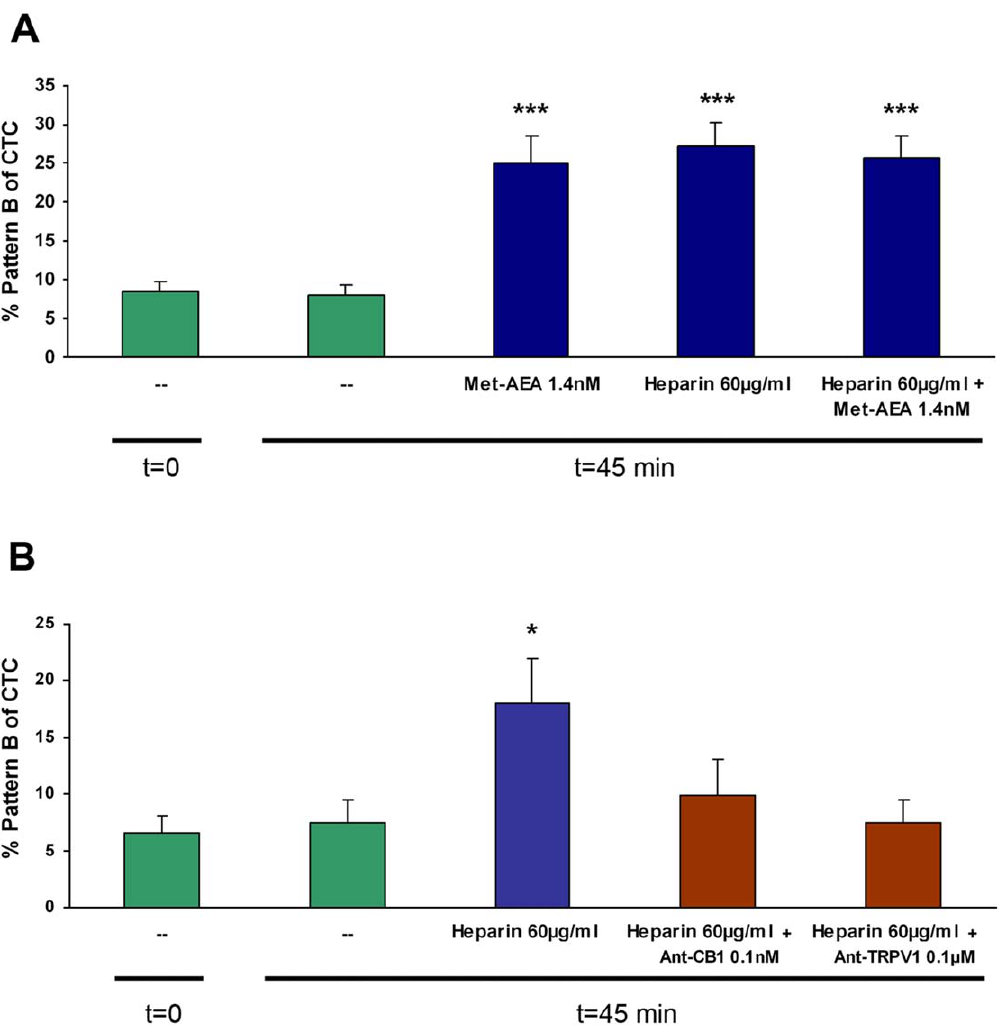
Figure 5. Effect of nanomolar concentration of Met-AEA and heparin on bull sperm capacitation. Spermatozoa were incubated for 45 min at 38.5 u C with different treatments. Bars indicate the percentage of capacitated spermatozoa (pattern B) determined by CTC. (t=0; t=45: controls). Data are expressed as mean 6 SEM. A : Met-AEA, Heparin or Met-AEA plus Heparin. ***p , 0.001 vs. control (n=6). B : Heparin, Heparin plus Ant-CB1 or Heparin plus Ant-TRPV1. *p , 0.05 Heparin vs. control, Ant-CB1 and Ant-TRPV1